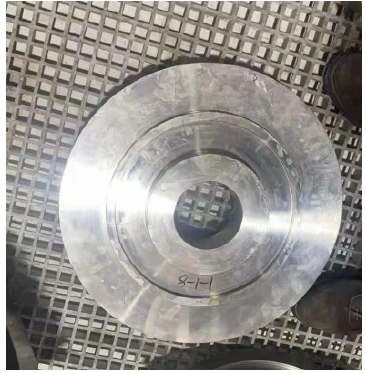
Figure 18. The final forgings produced.